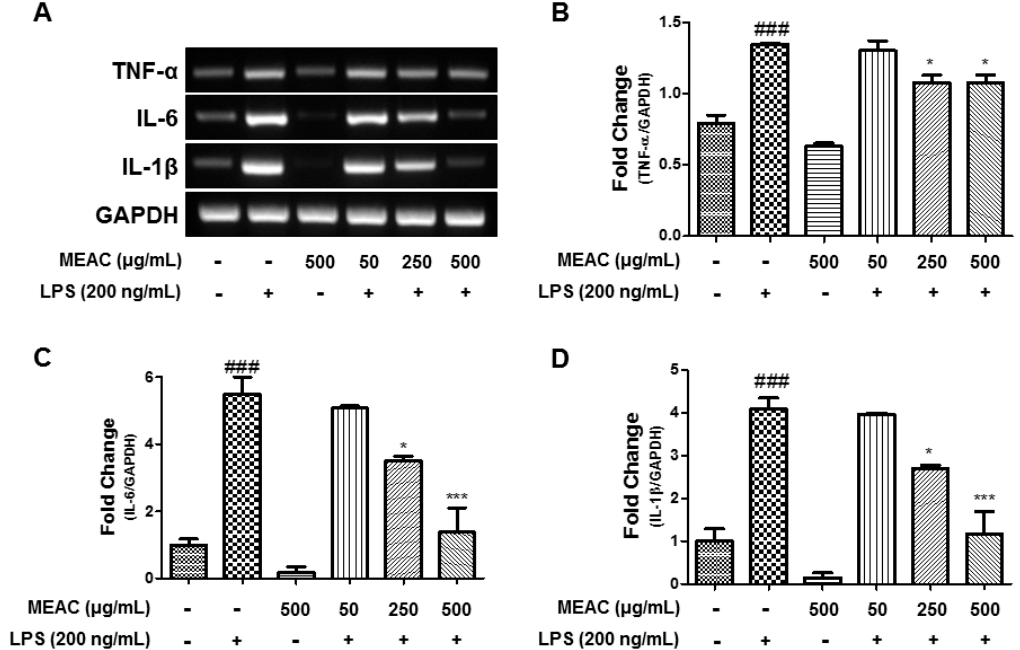
Figure 4. MEAC action on LPS-induced cytokine expressions in BV-2 microglial cells. ( A ) The regulation of TNF- α , IL-1 β , and IL-6 mRNA expressions by MEAC treatment ( A ). The representative densitometry analyses of TNF- α ( B ), IL-6 ( C ), and IL-1 β ( D ) compared with GAPDH mRNA. Data are presented as the mean ± SEM. ### p < 0.001 versus control group ( n = 3); * p < 0.05 and *** p < 0.001 versus LPS group ( n =